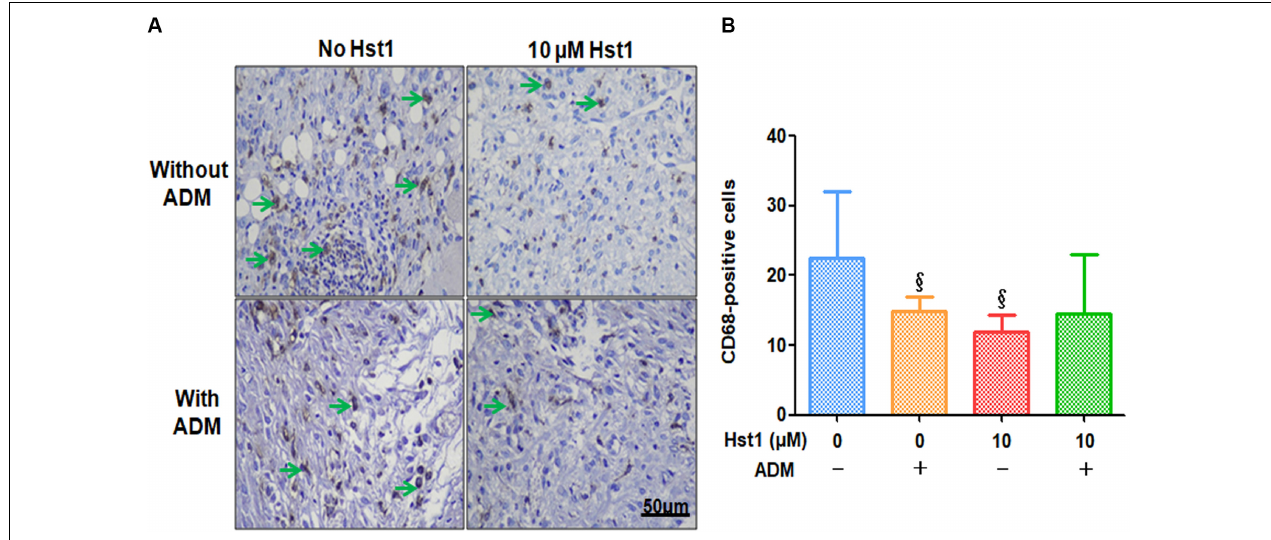
FIGURE 6 | Immunohistochemical evaluation of CD68-positive cells at wound sites. (A) 7 days post-surgery, the number of CD68-positive macrophages (in green arrows) in the groups of ADM (14.8 ± 2.0) and 10 µ M Hst1 group (12.0 ± 2.3) were significantly lower than the control group (22.6 ± 9.4). The scale bar = 50 µ m; (B) Quantitative analysis of the number of CD68-positive cells. The 10 µ M Hst1 group presented significantly lower amounts of macrophages compared with the control group. §: The 10 µ M Hst1 group and ADM group vs the control group ( P <